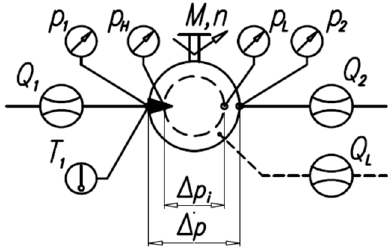
Figure 1. Parameters measured in a hydraulic motor: Q 1 , Q 2 and Q L —flowrate, p 1 and p 2 —pressure in the inflow and outflow port, respectively, p H and p L —pressure in the high-pressure and low- pressure working chamber respectively, M —load (torque), n —rotational speed, T 1 —temperature, ∆ p —pressure drop in the motor, ∆ p i —pressure drop in the motor working